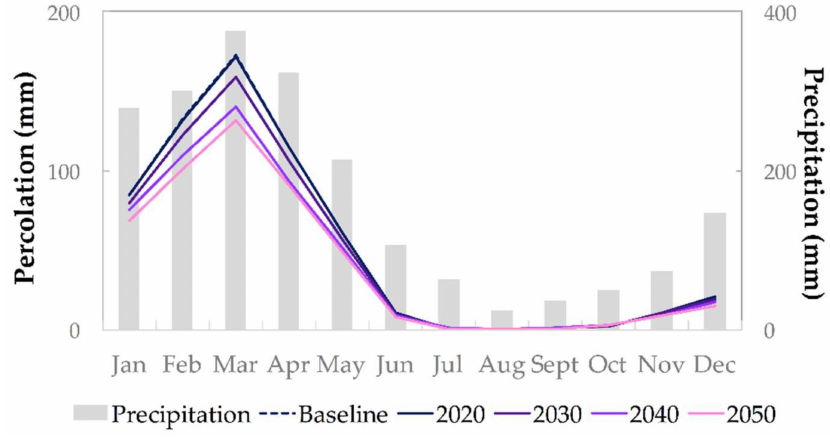
Figure 9. Monthly average simulated percolation for 2020, 2030, 2040, 2050, and the